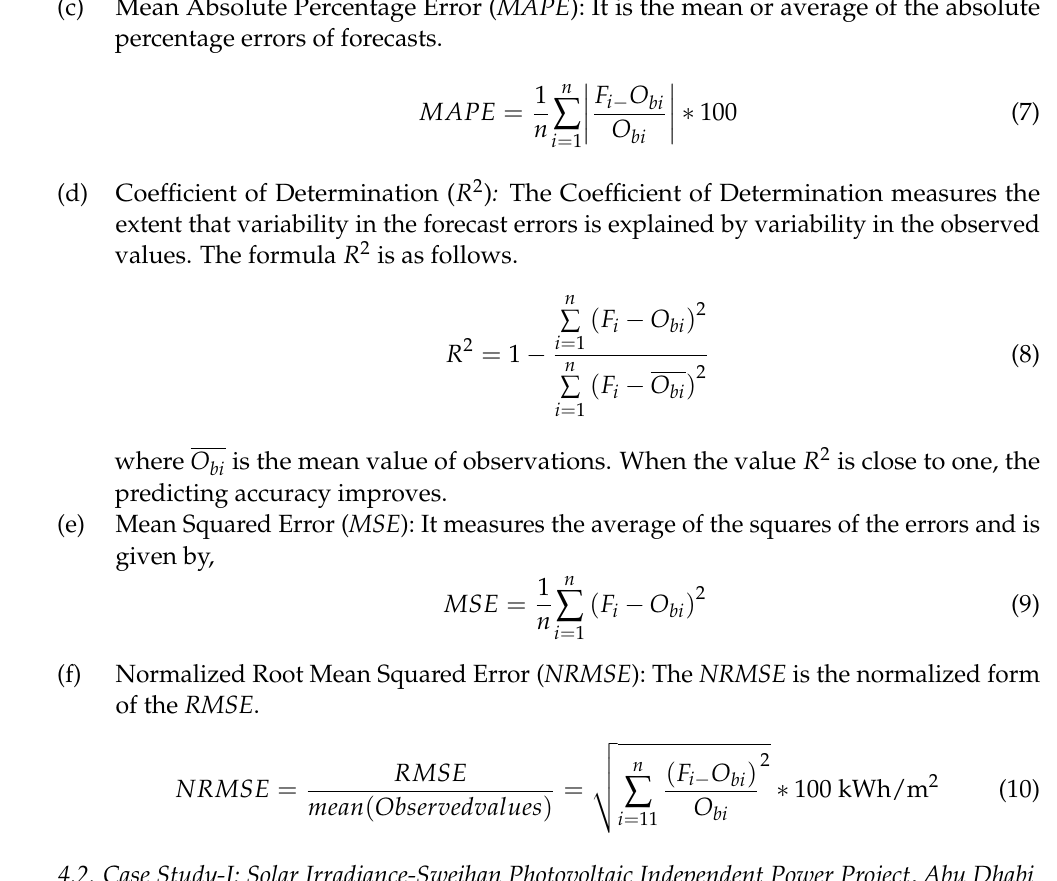
RMSE is a commonly used metric for evaluating solar forecasting accuracy. The errors are squared before they are averaged and hence it gives higher weight to large errors. When analyzing forecasts in circumstances where significant mistakes are undesired, the RMSE is used. Mean Absolute Percentage Error ( MAPE ): It is the mean or average of the absolute percentage errors of forecasts.